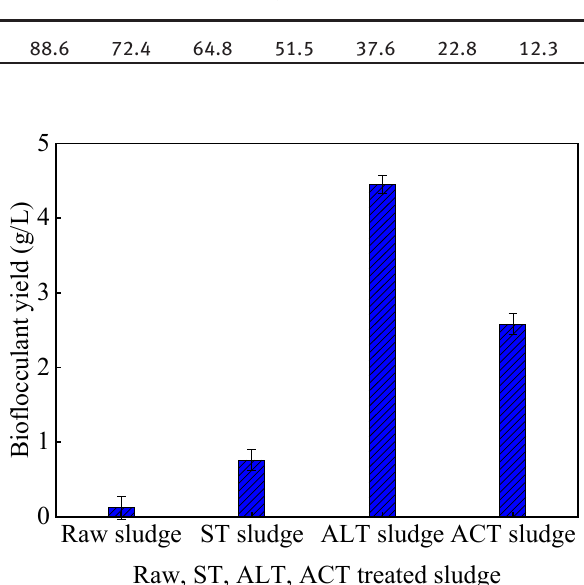
Table 1: Thermal stability of the bioflocculant harvested from ALT sludge. Temperature